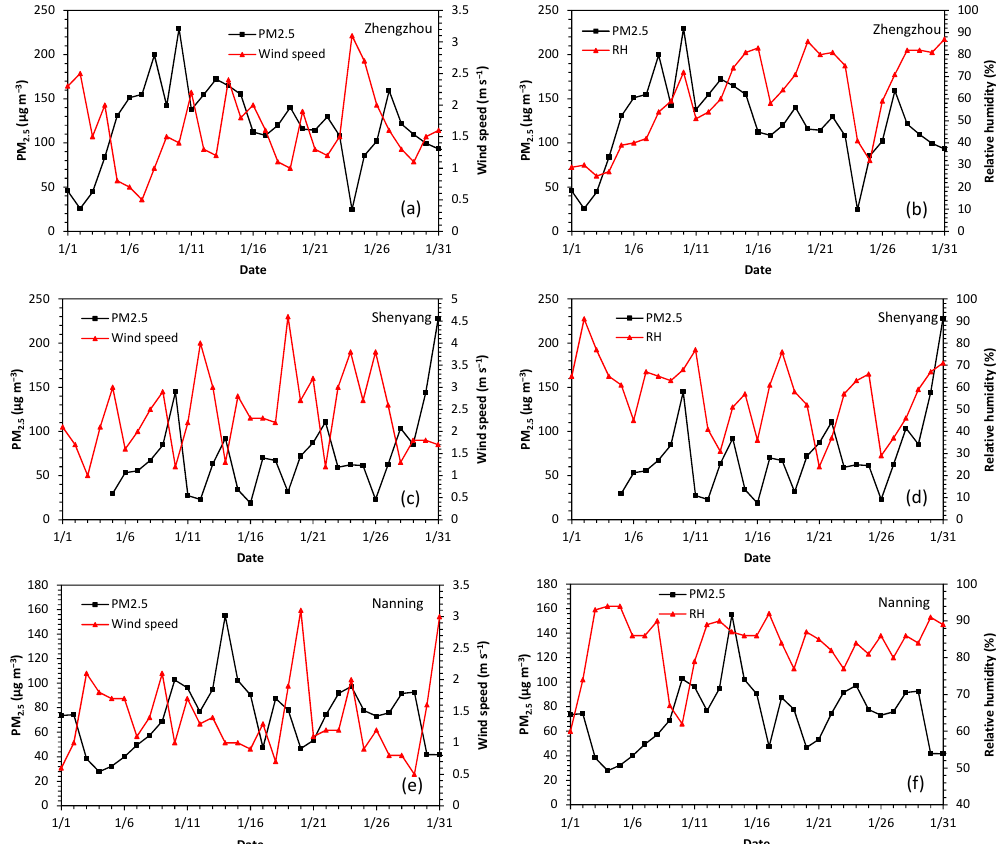
Figure 10. Daily averaged PM 2 . 5 concentrations vs wind speed and relative humidity at (a, b) Zhengzhou, (c, d) Shenyang and (e, f) Nanning in January